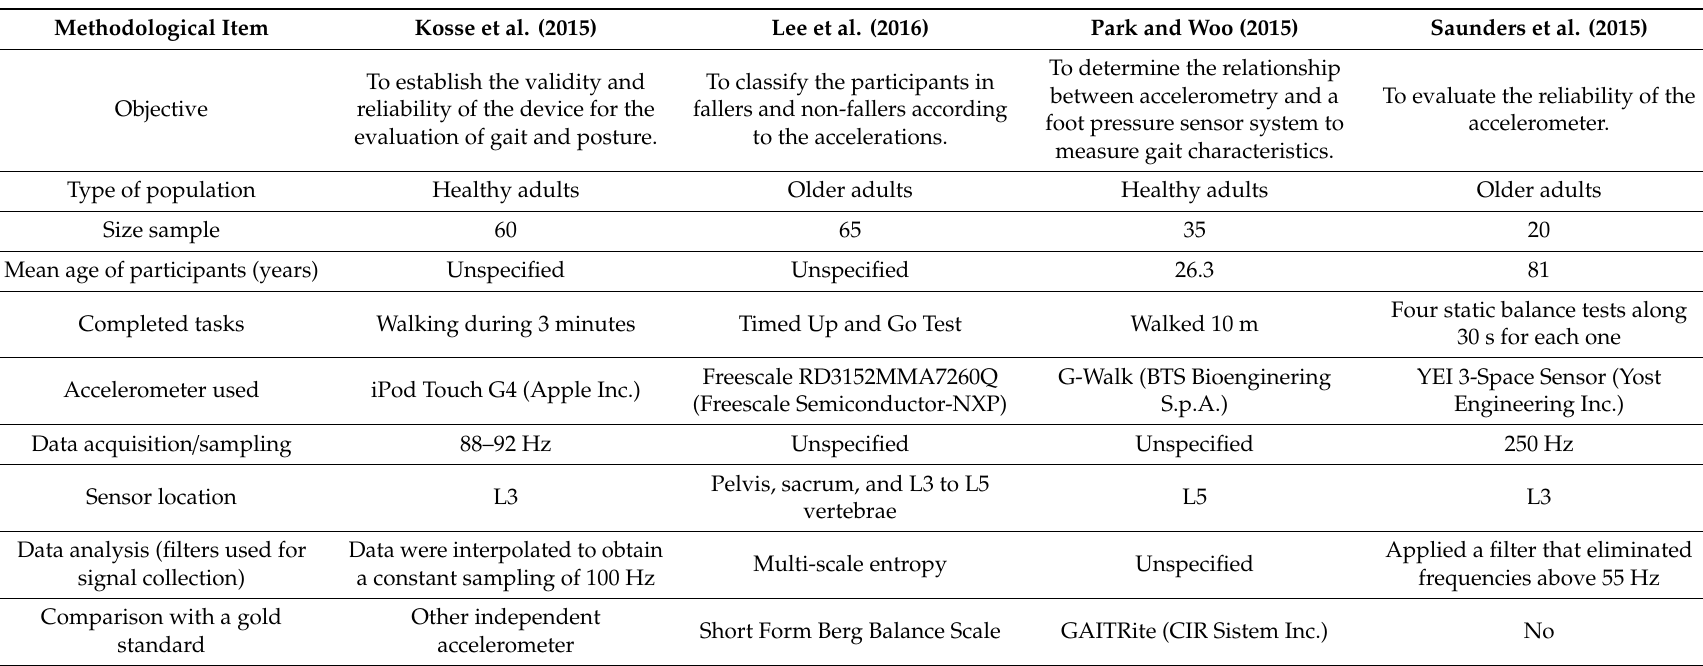
Table A5. Methodological details of the research